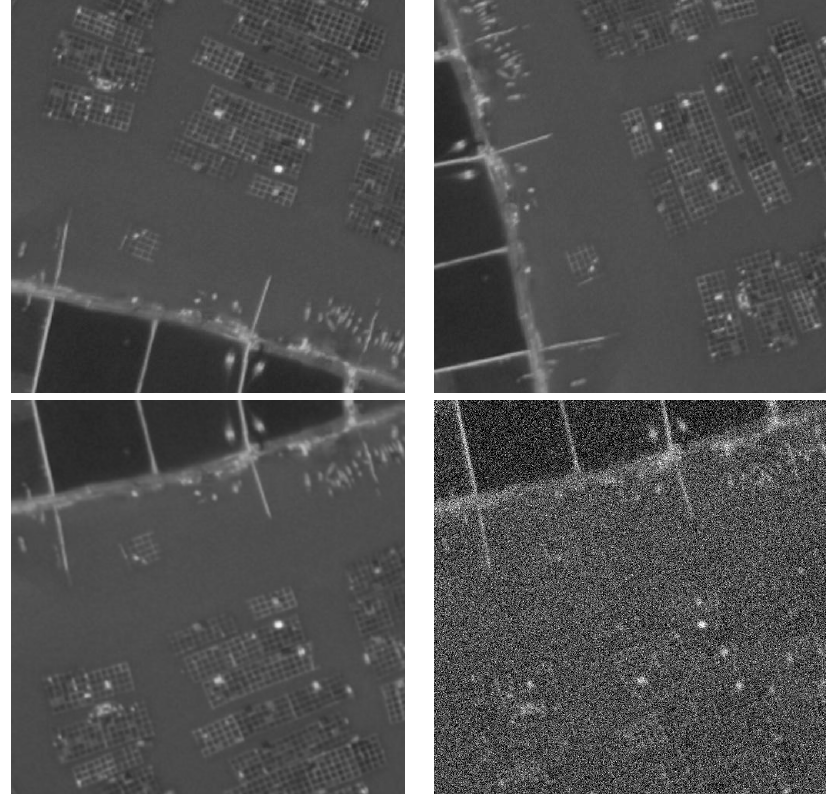
Figure 7. Results of data augmentation.